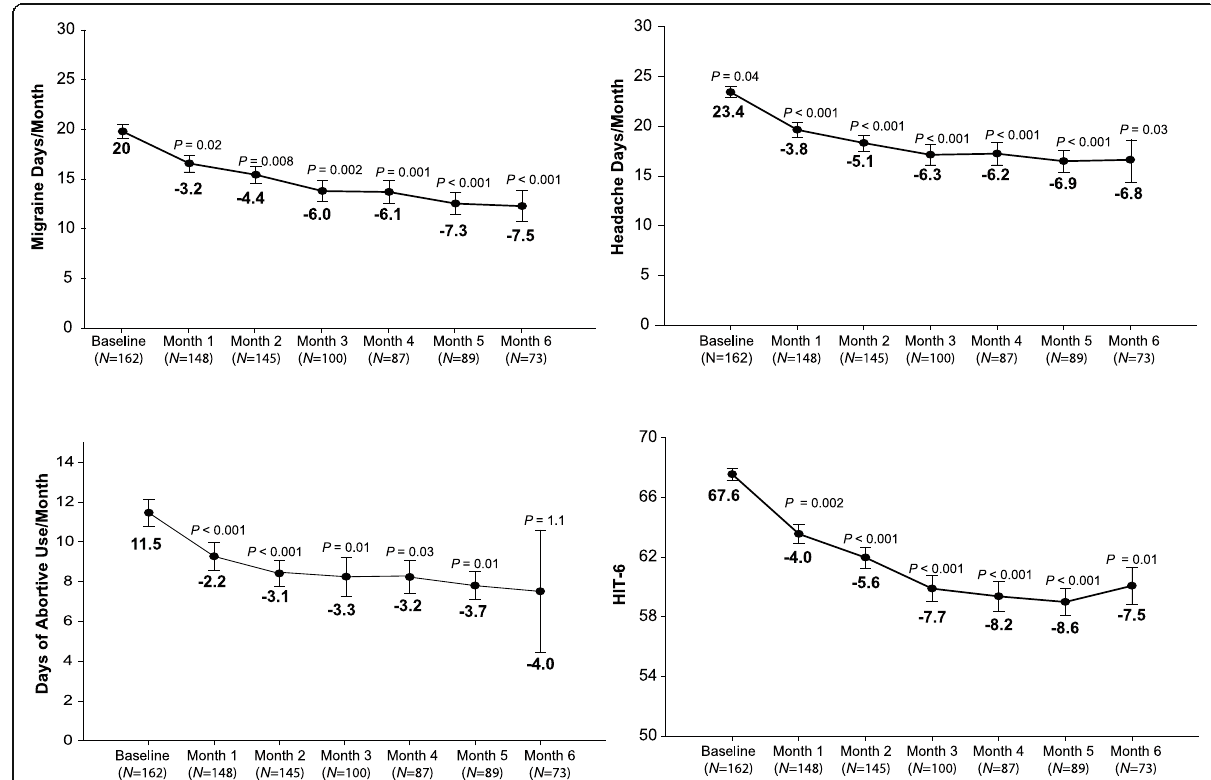
Fig. 2 Six-month outcomes on all patients treated with erenumab: Overall, during the entire six month observation period post-erenumab treatment initiation, monthly migraine days (MMD), headache days (MHD), days of abortive use and headache impact test (HIT-6) were significantly reduced compared to baseline (mean ± st. er.)